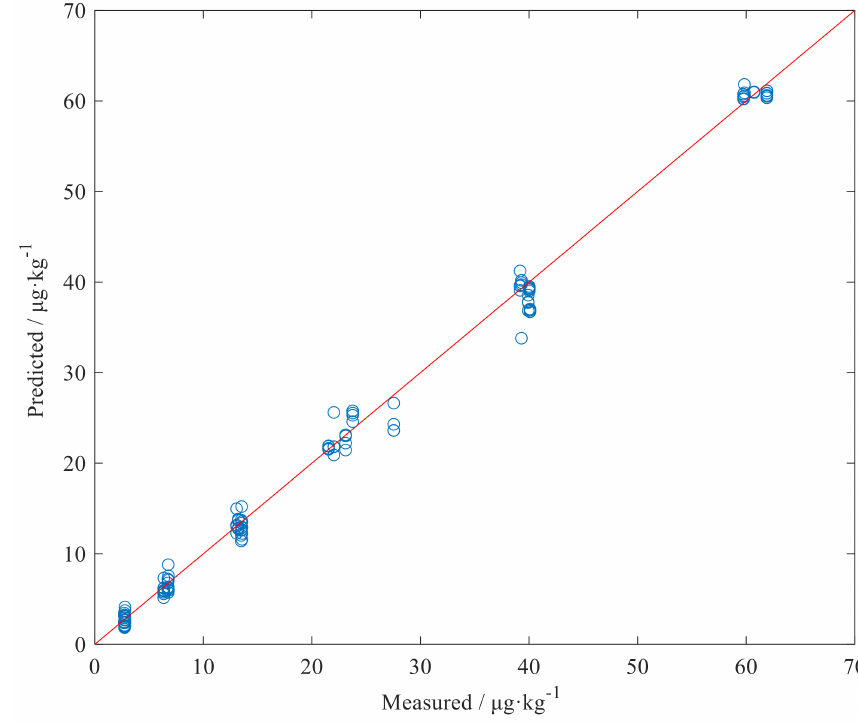
Figure 5. Comparison of measured and the 2D-MTF-CNN model predicted